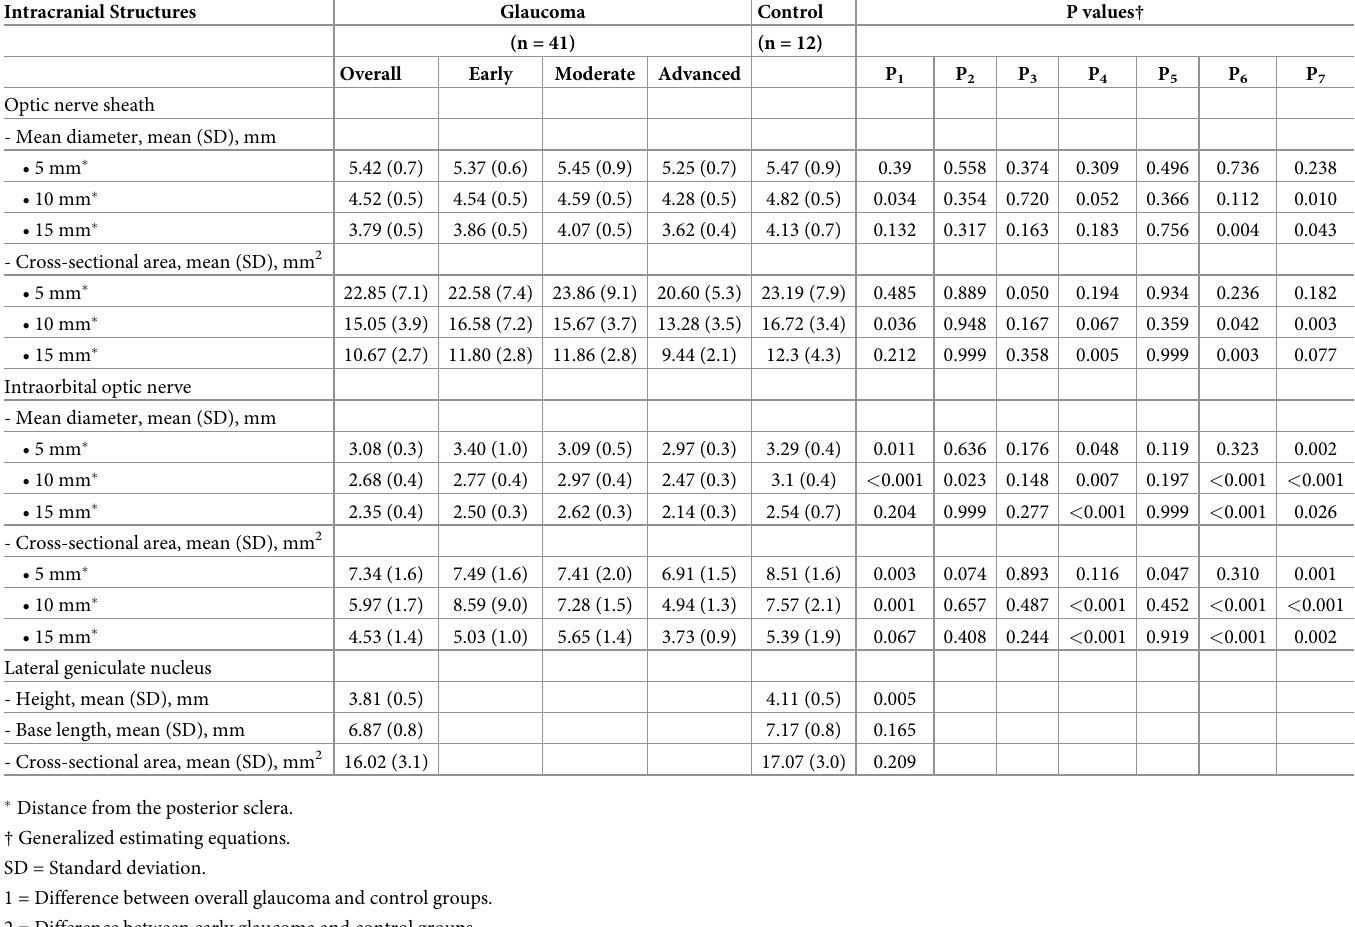
Table 3. Structural characteristics of the optic nerve sheath, intraorbital optic nerve and lateral geniculate nucleus measured with 3-Tesla magnetic resonance imag- ing based on the level of functional damage on standard automated perimetry. Intracranial